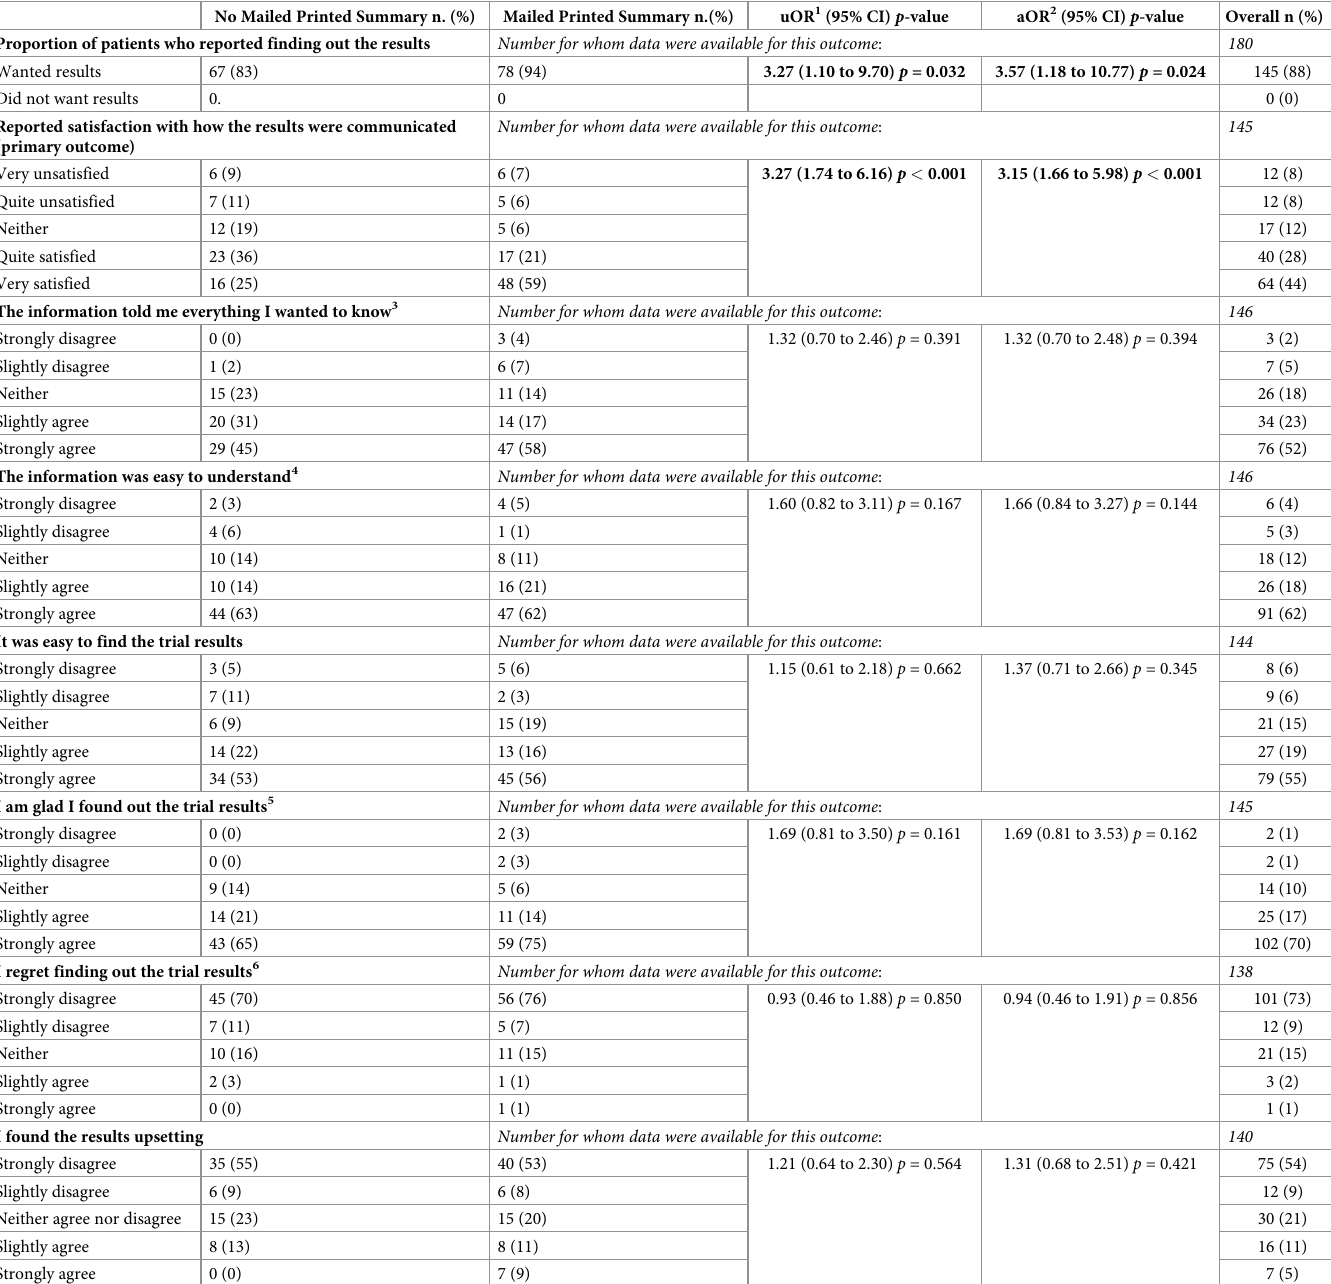
Table 5. Reported outcomes relating to experience of receiving the results by randomised intervention: Mailed Printed Summary versus no Mailed Printed Summary. No Mailed Printed Summary n.